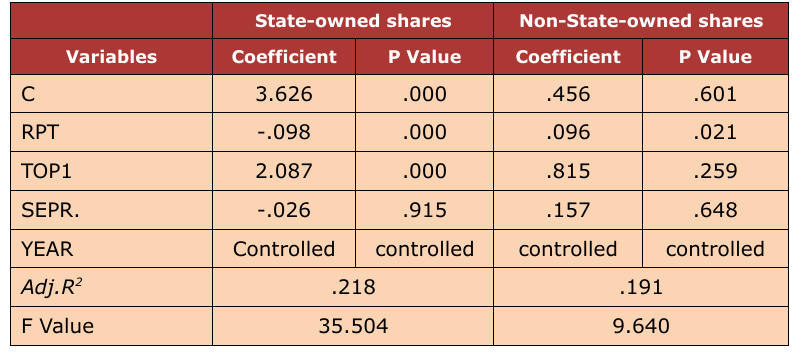
Table 5. Regression Result of Model